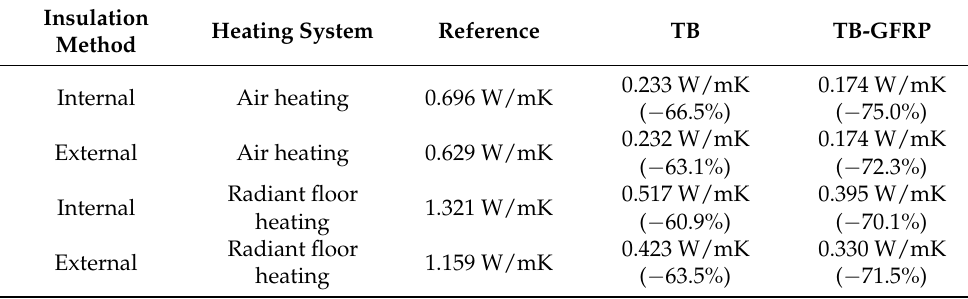
Table 7. Summary of analysis results on the linear thermal transmittance.